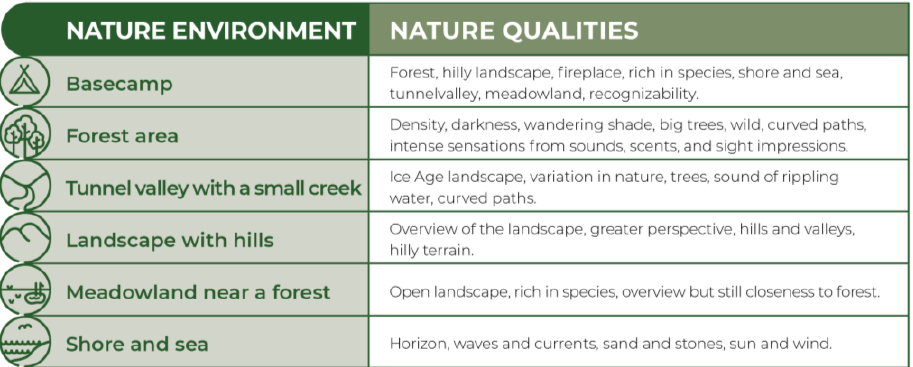
Figure 1. Nature environment .